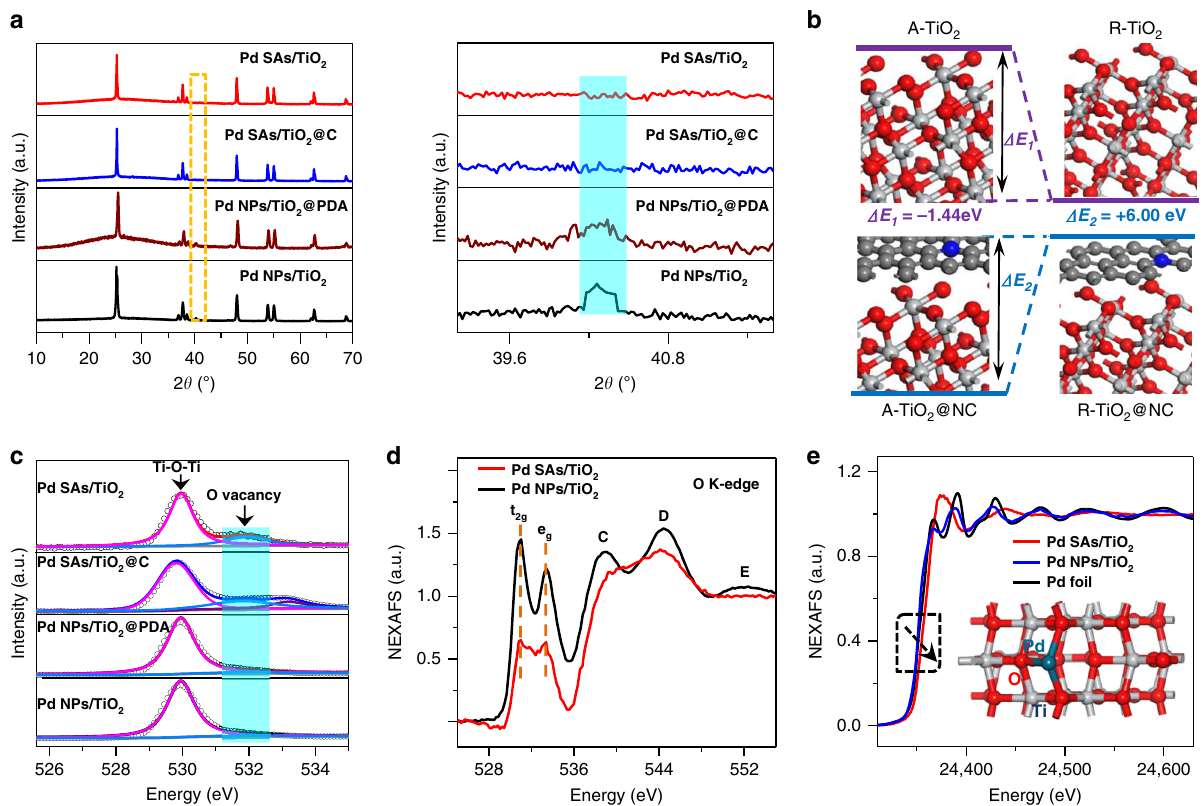
Fig. 3 Structural characterizations of Pd SAs/TiO 2 and reference materials. a XRD patterns. b Structure con fi gurations and the energy difference of/ between anatase TiO 2 (A-TiO 2 ) and rutile TiO 2 (R-TiO 2 ), anatase TiO 2 @N-doped carbon (A-TiO 2 @NC) and rutile TiO 2 @N-doped carbon (R-TiO 2 @NC). Silver white atoms represent Ti, red atoms represent O, gray atoms represent C and blue atoms represent N. c XPS spectra for samples during each synthetic step of N-doped C atomization. d O K-edge and e Pd K-edge NEXAFS spectra of Pd SAs/TiO 2 and Pd NPs/TiO 2 . Inset is the proposed Pd – O 3